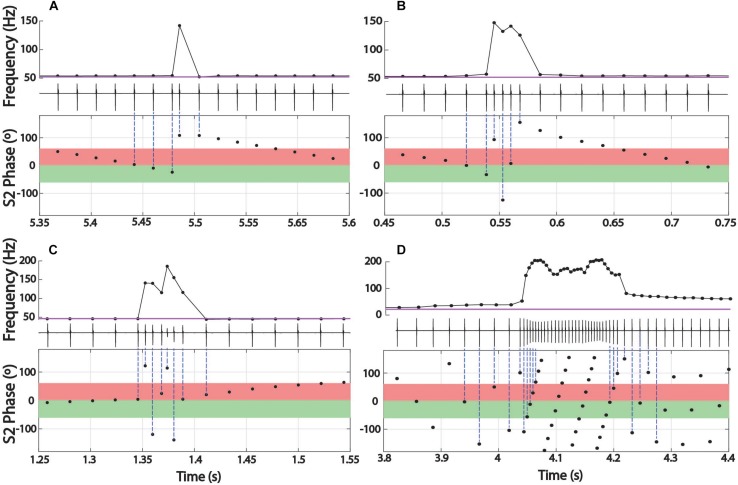
Phase precession during chirps. Three representative chirps in Steatogenys are shown, simple (A), long (B), and complex (C). A representative chirp from Brachyhypomous is shown in D. In each panel, the top subplot shows the instantaneous frequency, with the oscillogram trace directly below. The bottom subplot shows the phase of each S1 EOD with respect to the stimulus (S2). Each EOD is represented by a black circle, with dotted lines connecting to the chirp EODs for reference. The S2 frequency is depicted in the frequency plots by the horizontal purple line. In the phase plots, the 60° window before and after the S2 EODs is indicated by green and red boxes, respectively.